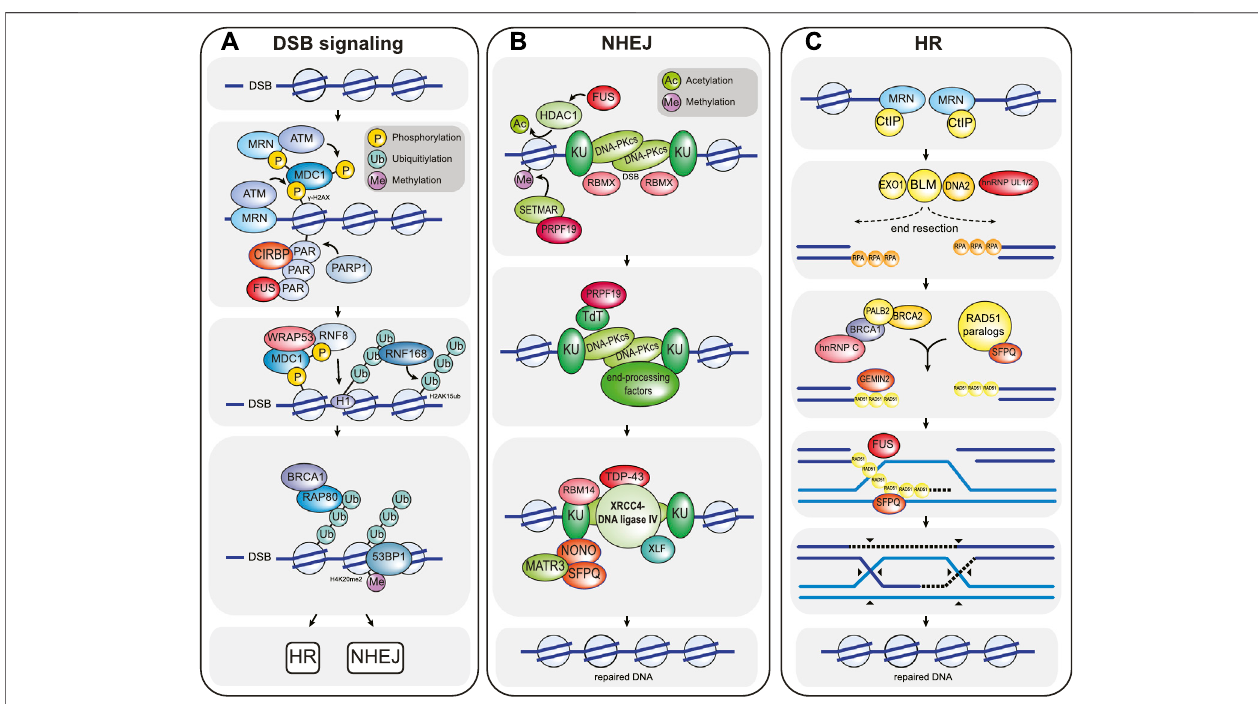
FIGURE 1 | Overview of the chromatin-based DSB response. (A) DSB signaling isinitiated by the MRN complex, which senses DSBs and recruits the ATM kinase to the damaged chromatin. Here, ATM phosphorylates the histone H2A variant H2A.X to form γ -H2AX, which in turn is recognized by MDC1. MDC1 is constitutively phosphorylated by CK2 (not shown) and activates a positive feedback loop by recruiting more MRN and ATM to the break site. In addition, MDC1 is phosphorylated by ATM, and this phosphorylation event triggers the recruitment of the E3 ubiquitin ligase RNF8. RNF8 in turn ubiquitylates histone H1, which is then bound by a second E3 ubiquitin ligase called RNF168. RNF168 ubiquitylates histone H2A at residues K13/K15 (H2AubK13/15). The resulting ubiquitin signal is bound by multiple proteins, including RNF168 itself (to create a second positive feedback loop that locally ampli fi es the DNA damage signal) and the DSB repair pathway choice proteins BRCA1and53BP1.BRCA1recognizesubiquitylatedchromatinviaitsinteractionpartnerRAP80andpromotesHR-mediatedDSBrepair.Incontrast,53BP1isenriched atdamagedchromatinbysimultaneouslybindingtoRN168-ubiquitylatedH2AandtoconstitutivelymethylatedhistoneH4K20me2,andpromotesNHEJ-mediatedDSB repair.CIRBP,WRAP53,andFUSareexamplesofRBPsthatmodulateDSBsignaling.CIRBPenhancestheaccumulationofMRN-ATMattheDSBsite,whileWRAP53 facilitates RNF8 recruitment by stabilizing the MDC1-RNF8 interaction. FUS likely promotes the retention of signaling and repair factors by participating in phase separation around the break DSB site. (B) NHEJ-mediated DSB repair is initiated when DSB ends are recognized by the KU proteins, followed by recruitment of the kinaseDNA-PKcs.KU-DNA-PKcsmostlyactasascaffoldtorecruitnumerousDNAend-processingfactors(includingTdTandmanyotherssuchasDNApolymerases λ and μ , Artemis, PNKP, and TDP1; not shown) that create DNA ends compatible for re-ligation. Following DNA end-processing, the DNA ligation complex XLF-XRCC4- DNA ligase IV is recruited to the DSB to re-join the broken DNA ends. Numerous RBPs promote NHEJ. For example, FUS enhances NHEJ by recruiting the histone deacetylase HDAC1 and as such enhancing local chromatin remodeling. RBMX binds to DSB ends to prevent DNA end-resection. PRPF19 recruits the histone methyltransferase SETMAR, which enhances the recruitment of NHEJ factors such as KU, and also binds to the DNA end-processing factor TdT. TDP43, RBM14, and SFPQ-NONO act as scaffolds that stabilize the assembly of the DNA ligation complex. (C) HR-directed DSB repair is initiated by extensive DNA end-resection by the nucleasesCtIP, MRE11 (which is part ofthe MRN complex), EXO1 and DNA2-BLM. DNAend-resection generateslong single-stranded DNA overhangsthat are rapidly bound by RPA. Next, with the help of numerous mediator complexes, including the BRCA2-PALB2-BRCA1 and the RAD51 paralog complexes, RPA is exchanged for the DNA recombinase RAD51. The resulting RAD51 nucleoprotein fi lament then searches for homologous sequences elsewhere in the genome (usually the sister chromatid), whereitthencatalyzes strand invasiontoformaDNAcrossover calledaHolliday junction.Thisgeneratesaprimerfor DNAsynthesis (dashedlines), whichis extended by branch migration away from the crossover site. After DNA repair, the joint DNA molecules are resolved by cleavage of the crossed or non-crossed DNA strands (black arrowheads). The RBPs hnRNP UL 1 and 2 enhance DNA end-resection by stimulating BLM recruitment. hnRNPC, GEMIN2 and SFPQ support the formationoftheRAD51nucleoprotein fi lament.Inaddition,GEMIN2,SFPQ,andFUSalsostimulatestrandexchange.NotethatDSBsignalingandrepairreactionrequire many additional factors, posttranslational modi fi cations and various species of local non-coding RNAs that are not depicted. Selected RBPs that participate in the chromatin-based response are highlighted in red in all three panels. Additional RBPs that participate in DSB signal transduction and repair are listed in Table 1